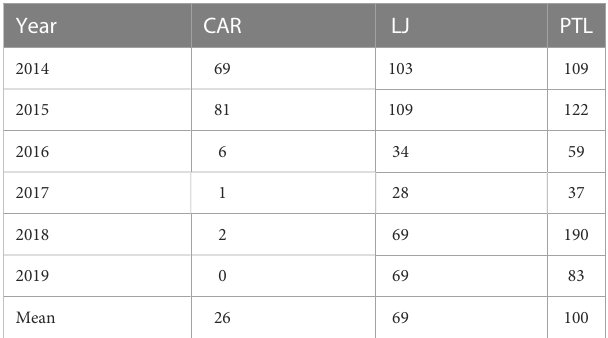
(Figure 4B). The total daily water column integrated NO 3- exposure (mol-days m -2 ) over the 11-mo time series differed across sites, with maximum values at Point Loma (28.45) followed by South La Jolla (25.06), Cardiff (23.61), and North La Jolla (18.61). For the full study period the high frequency components of NO 3- exposure associated with internal waves accounted for 4.4 to 8.7% of the totals with greatest contribution at Point Loma, while lower